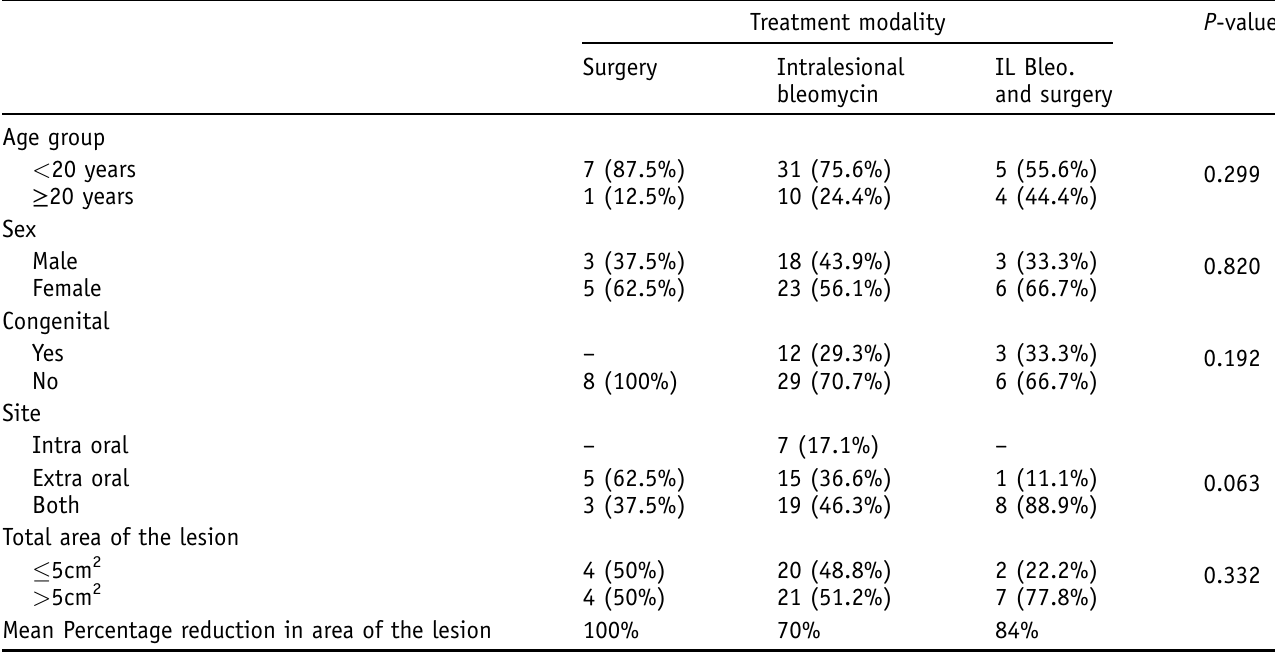
NB: The last row of the third column presents % reduction in size of the lesions after bleomycin injection and before surgery was carried